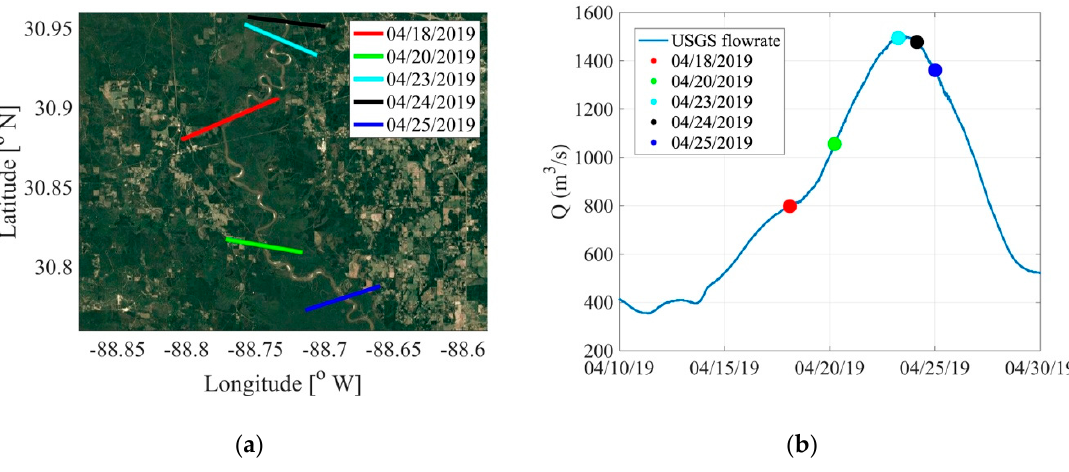
Figure 4. April 2019 raw IF data collections over the Pascagoula River: ( a ) track locations; ( b ) corresponding flowrates at the time of each overpass (color coded to match the track locations plotted on the left), plotted over the USGS flowrates over the time period spanning the data